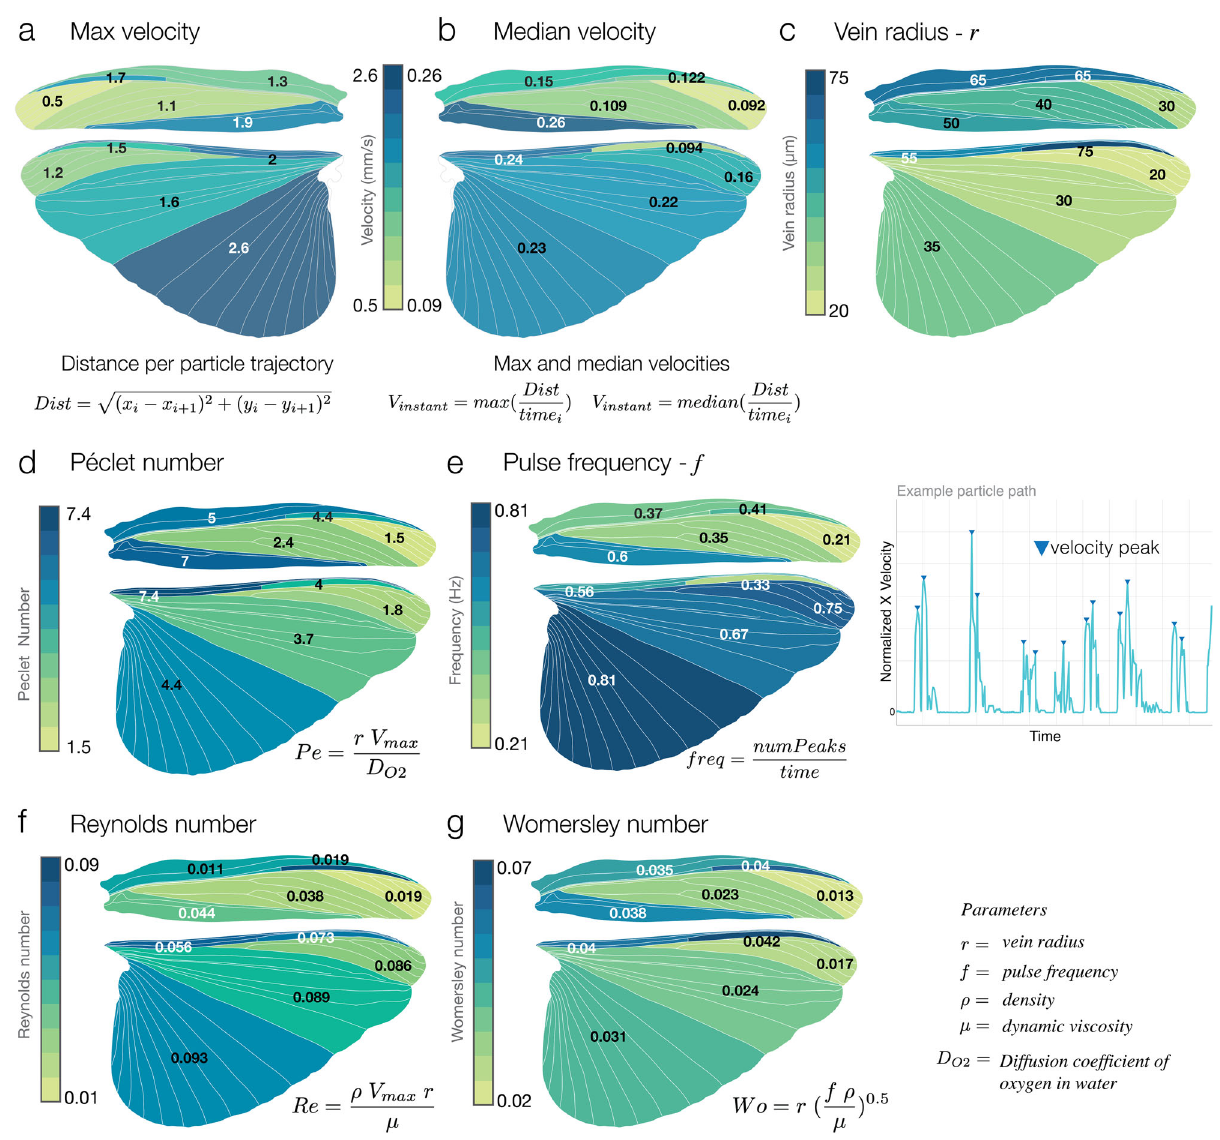
Fig. 4 Flow dynamics across wing regions. a and b Maximum and median velocities per wing region. Faster fl ows occur in the trailing edge of the forewing and the leading edge of the hindwing. c Average vein radius per region ( n = 25 vein radii measured, and average taken). d Average Péclet number for each region, where the diffusion coef fi cient, D O 2 , is for oxygen in the water. e Average pulse frequency, calculated by a number of velocity peaks over time (right of e ), increases in the trailing edge. f Average Reynolds number, inertial to viscous forces, describes a viscous fl ow regime in all regions (1<). g Average Womersley number, pulsatility to viscous fl ows, describes fl ow similar to venules 42 . Particle trajectories were placed on a normalized wing coordinate system ( n = 8 individual grasshoppers and 500 digitized particles).